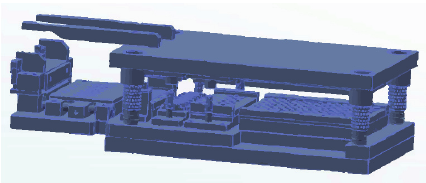
Figure 6: Multistation progressive stamping die for the heat exchanger